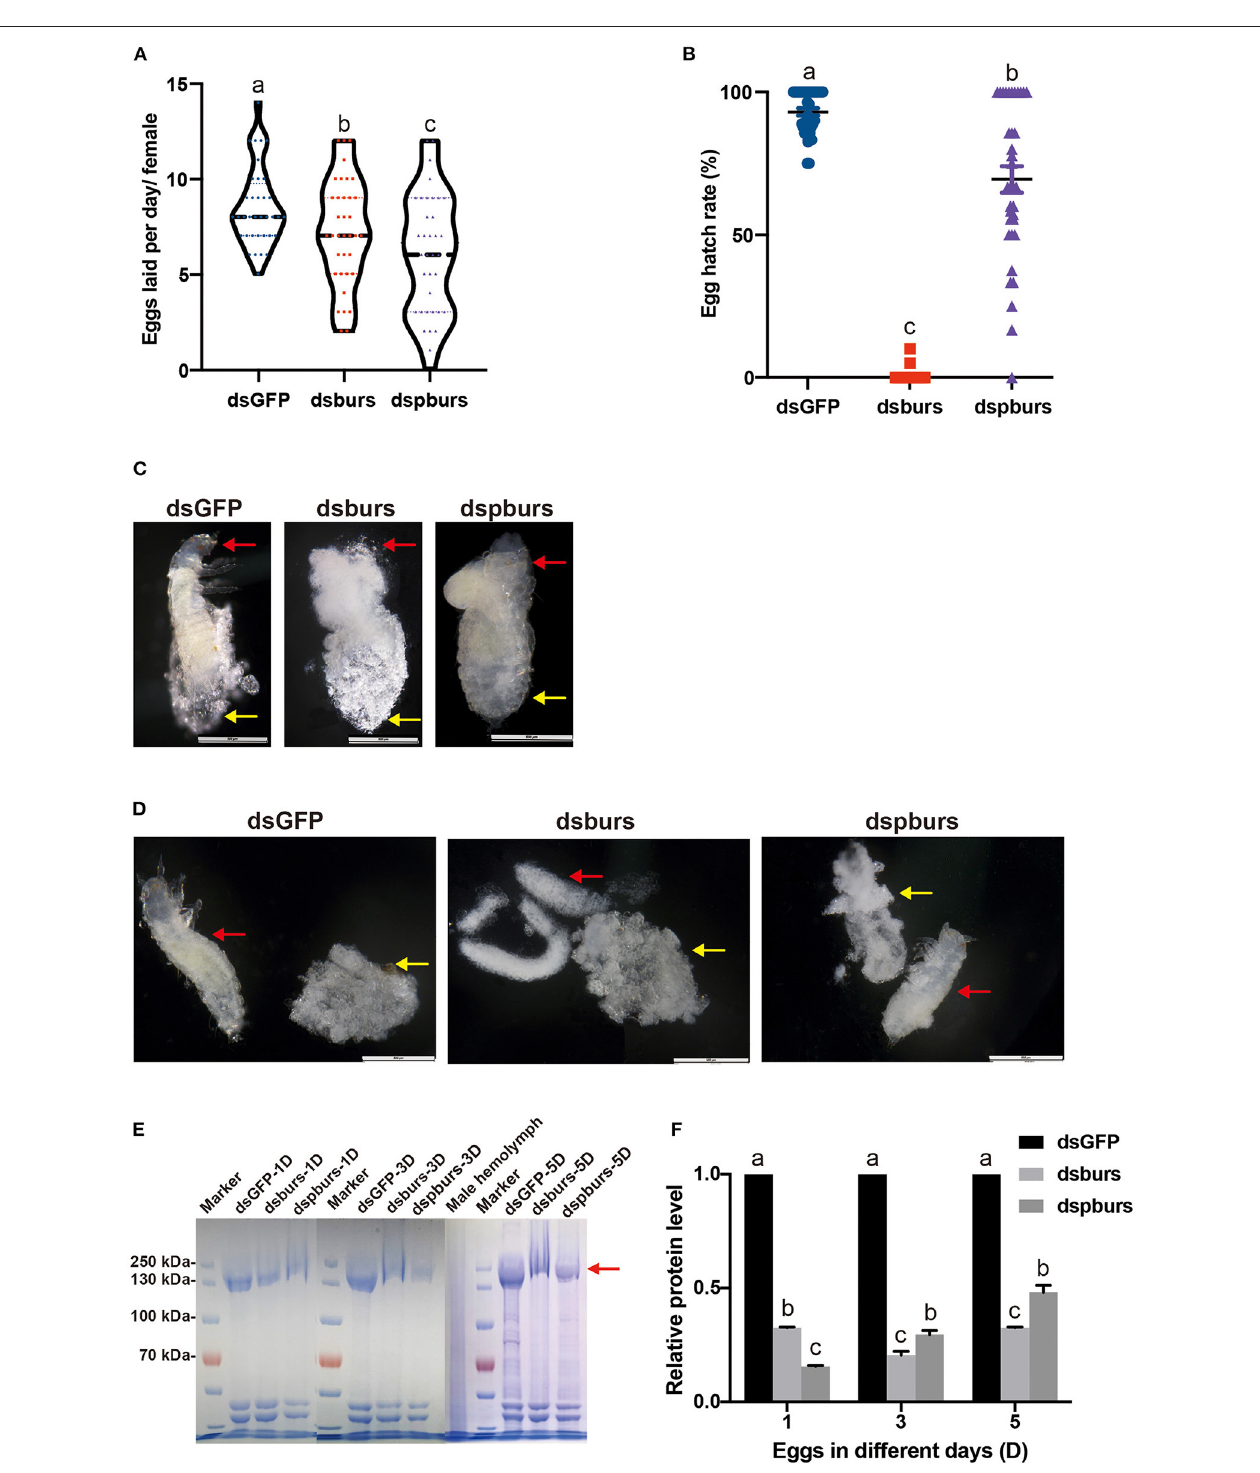
FIGURE 4 | Effects of dsburs and dspburs treatments on egg production, hatch rate, morphology, and protein content. (A) The number of eggs laid per day per female in dsGFP-, dsburs-, and dspburs-treated beetles. (B) Egg hatch rate in dsGFP-, dsburs-, and dspburs-treated females after mating. (C) The morphology of 5-day eggs from dsGFP-, dsburs-, and dspburs-treated groups. (D) Eggshells and immature larvae from 5-day eggs from dsGFP-, dsburs-, and dspburs-treated groups. The red arrows indicate the larvae, and the yellow arrows indicate the eggshells. (E) Protein in 1-, 3-, and 5-day eggs from dsGFP-, dsburs-, and dspburs-treated groups. (F) The quantification of vitellogenin (Vg) protein bands in the Coomassie Brilliant Blue-stained gel (E) . The bars represent the means ± SEM. Different letters on the bars indicate the means ± SEM, which are significantly different ( p < 0.05) among treatments by ANOVA.